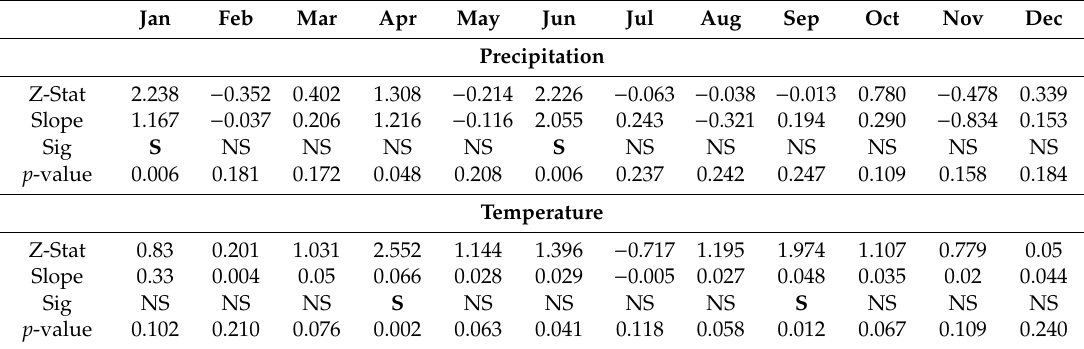
Table 3. Trend analysis and significance test for monthly precipitation and temperature in the LEC Watershed.